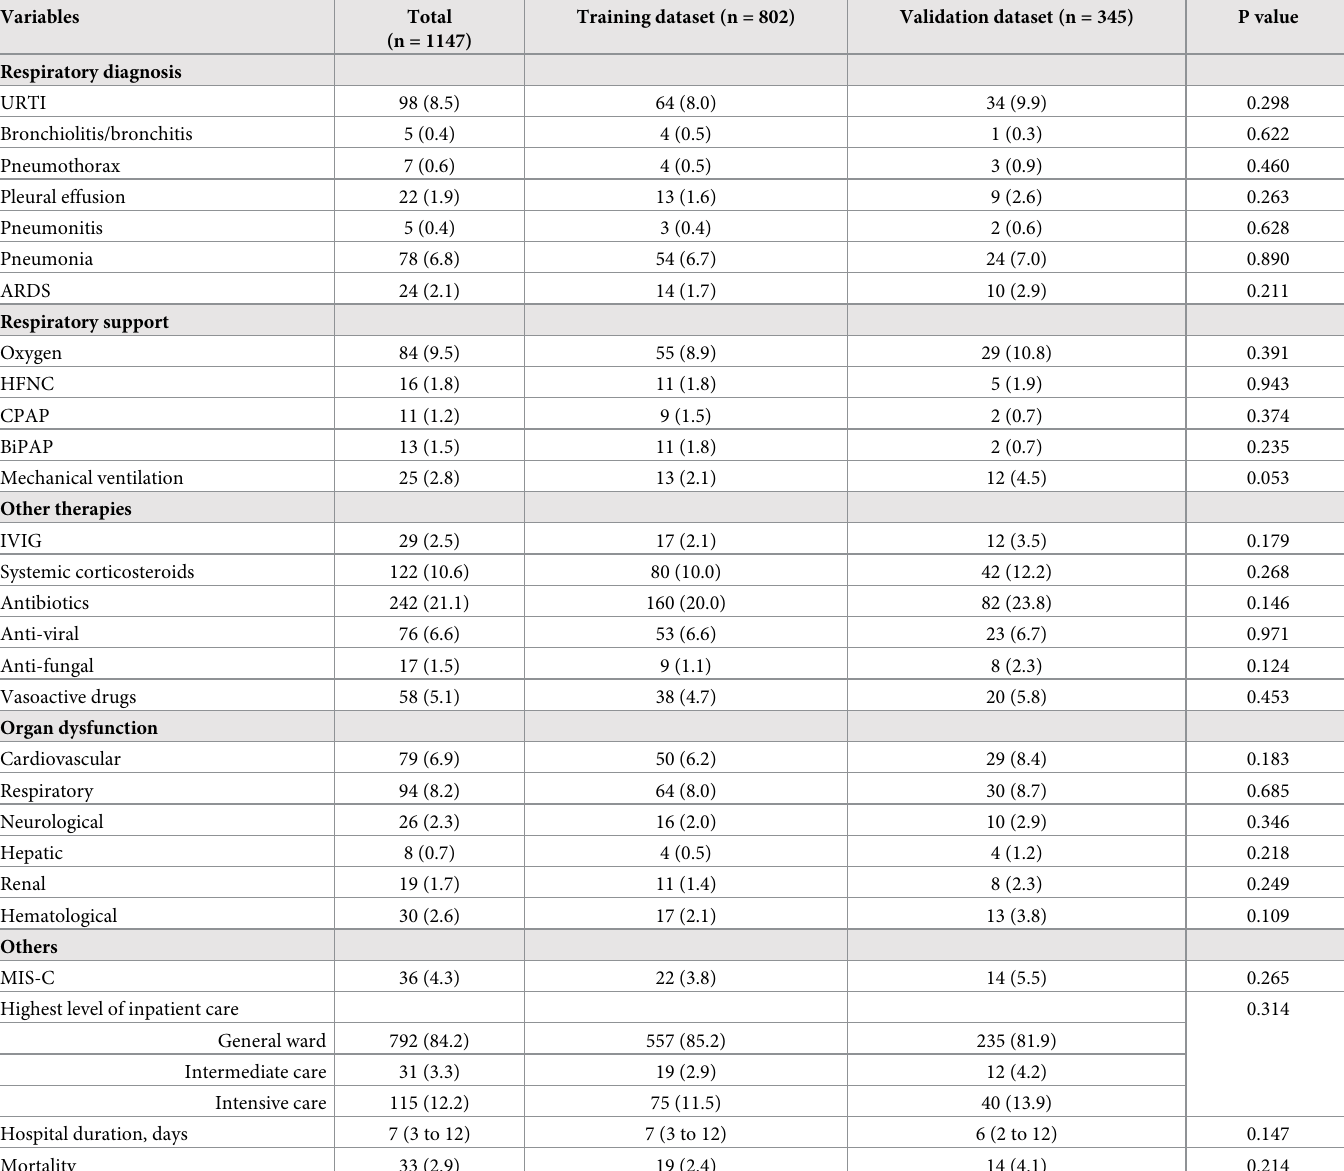
Table 2. Diagnosis, complications, therapies and outcomes for patients in the training and validation